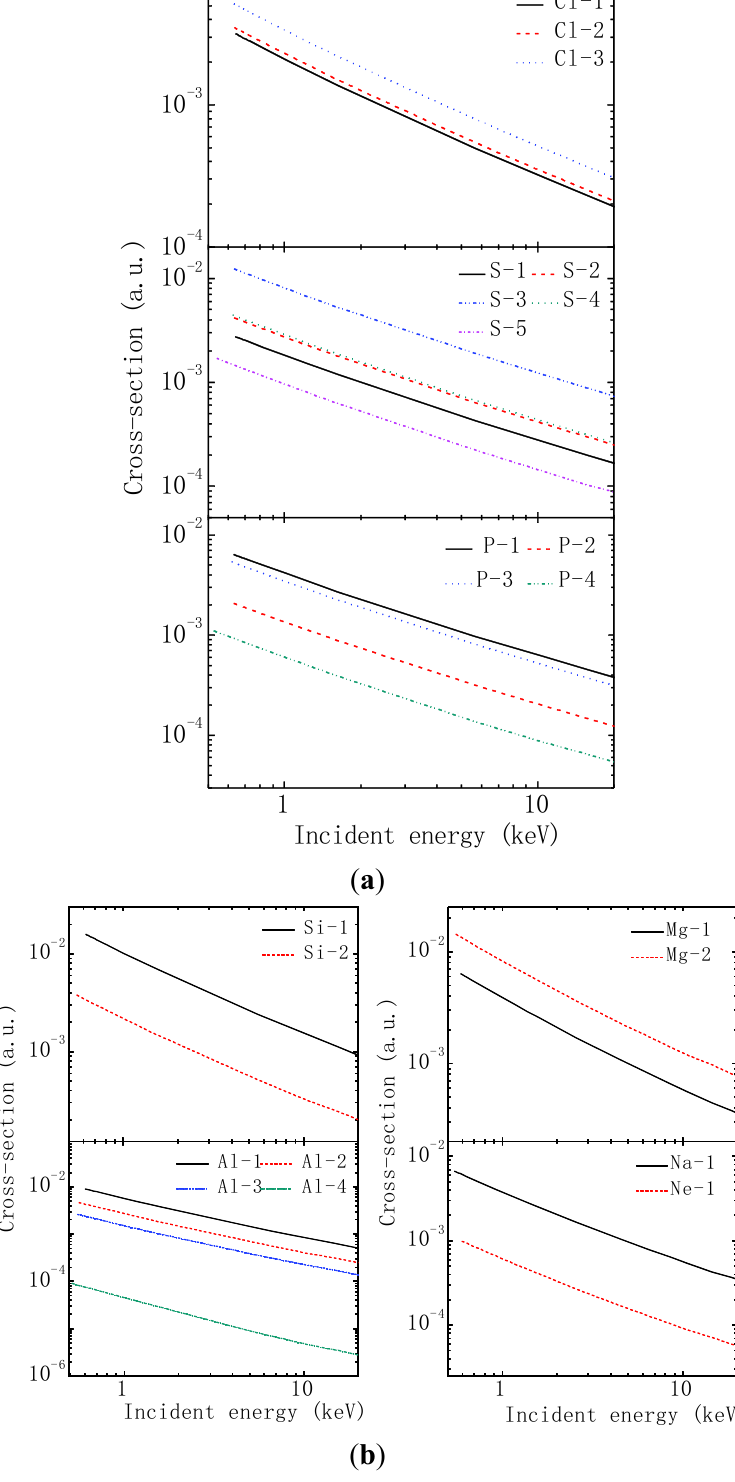
Figure 2. ( a ) Electron-impact excitation cross-sections (in atomic units) for different transitions as given in Table 6 for Cl-like, S-like and P-like tungsten ions as a function of incident electron energy; ( b ) Electron-impact excitation cross-sections (in atomic units) for different transitions as given in Table 6 for Si-like, Al-like, Mg-like, Na-like and Ne-like tungsten ions as a function of incident electron